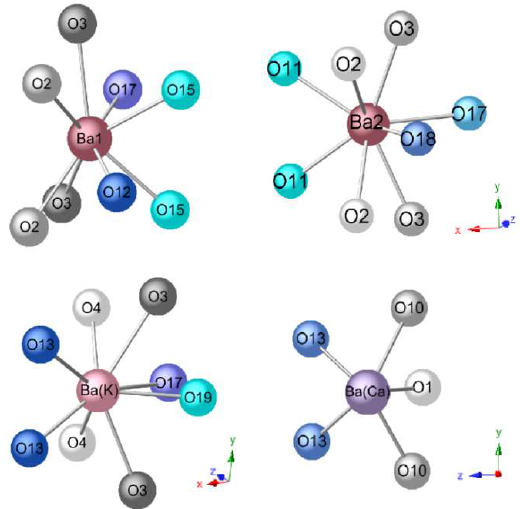
Figure 7. Coordination spheres of the barium positions in the structure of Ba-clinoptilolite (90 °C, 22 d)